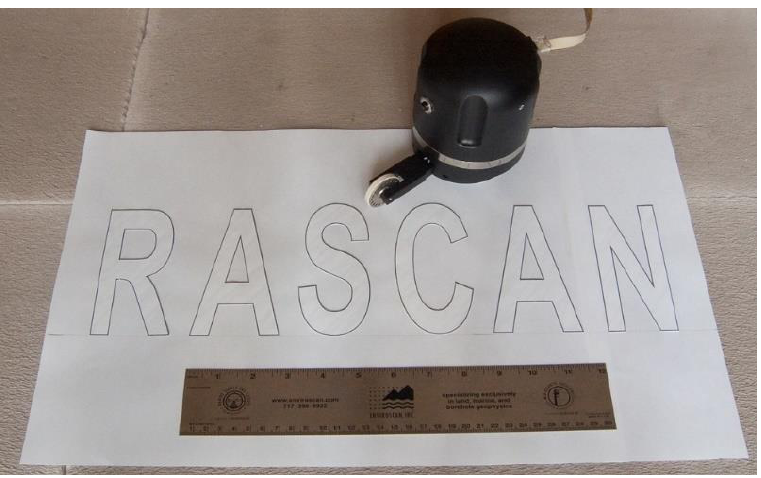
Figure 5. Paper sheet with aluminum foil letters (ruler is 12 inches, or 30.48 cm). R holograms Number of plaster sheets over letters